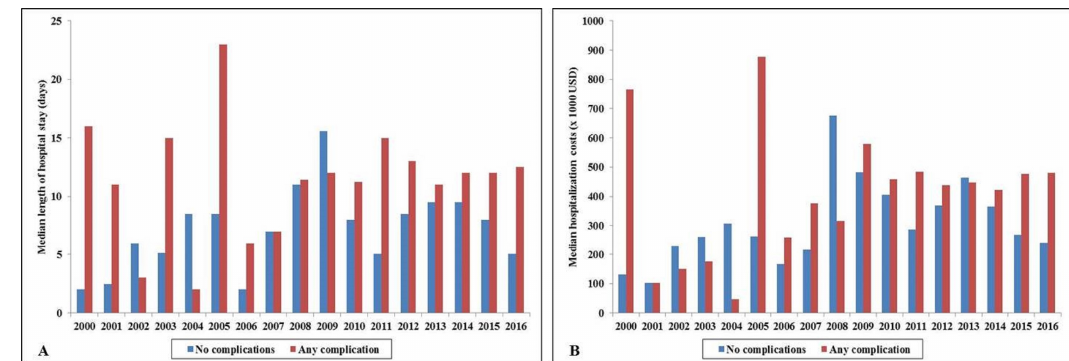
Figure 2. In-hospital resource utilization in acute myocardial infarction admissions supported by extracorporeal membrane oxygenation with and without complications. ( A ) Seventeen-year temporal trends of median length of stay in admissions with and without complications; p < 0.001 for trend; ( B ): 17-year temporal trends of median hospitalization costs in admissions with and without complications; p < 0.001 for trend. USD: United States Dollars. Table 1. Predictors of in-hospital mortality.